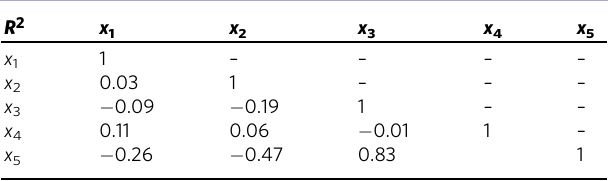
Table 6 The multicollinearity test on entrepreneurial change management measures.